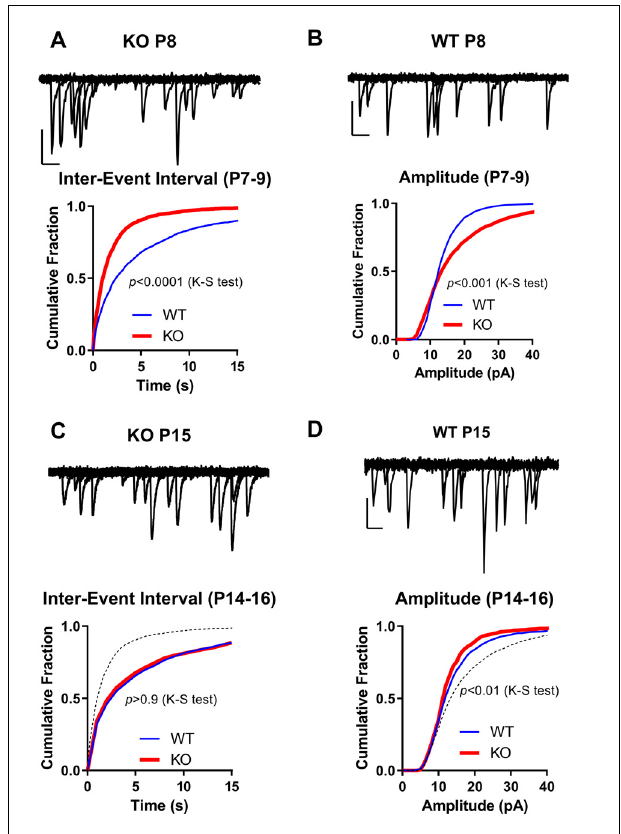
FIGURE 4 | Spontaneous miniature EPSCs in FMRP KO slices. (A–D) Cumulative distribution of Inter-Event Intervals (A,C) of spontaneous events in CA1 neurons recorded at − 60 mV in the presence of TTX and the amplitude of those events (B,D) from WT (blue line; n = 19–29) or FMRP KO slices ( n = 31–31). (A,B) P6–9. (C,D) P14–16. Kolmogorov-Smirnov (K-S) test p -value is shown in the figure. For comparison, superimposed on Figure C is WT P6-9 (dotted black line; from A ). Note the large increase in frequency of mEPSCs (decrease in Inter-Event Intervals) and in the amplitude of those events in KO neurons from slices P6-9. On top of each graph are shown 10 superimposed 250 ms long mEPSC events of KO P8 (A) , WT P8 (B) , KO P15 (C) , and WT P15 (D) . Scale bars: X-axis: 20 ms; Y-axis: 20